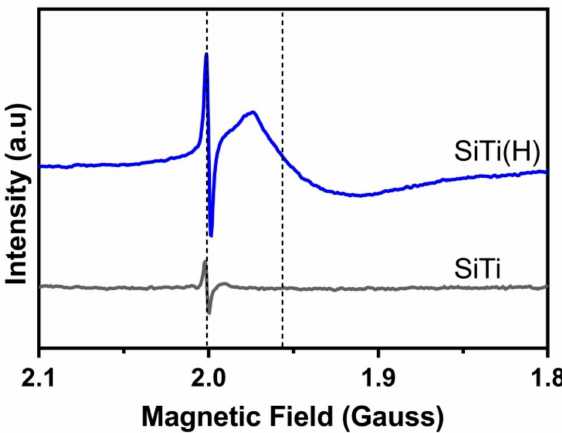
Figure 1. EPR spectra of the FSP-prepared SiTi before and after hydrogenation at 500 ◦ C. Spectra were acquired at 120 K. Dotted lines indicate the presence of defects within the